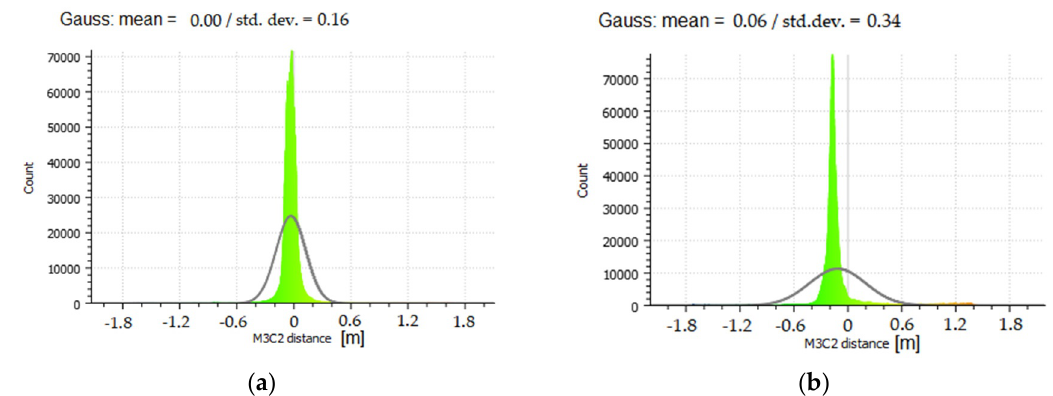
Figure 13. The M3C2 distance for the integrated point clouds: ( a ) the distance projected onto TLS points; ( b ) the distance projected onto UAV points.